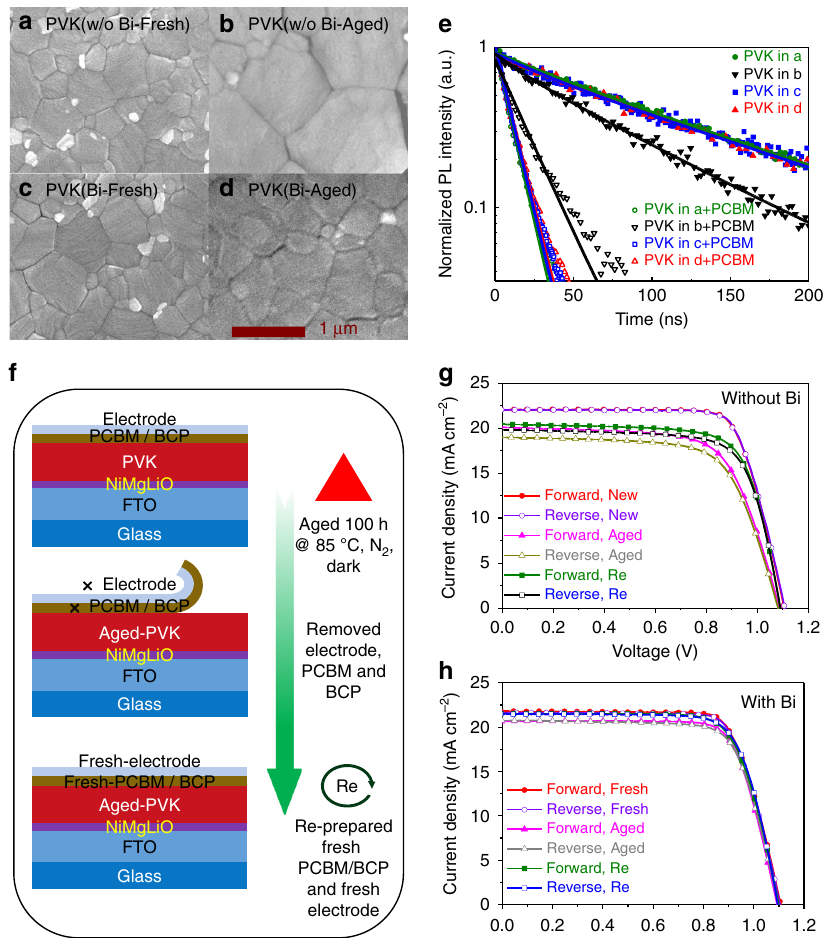
Fig. 5 Changes of PVK layers during thermal aging. a – d SEM images (scale bar: 1 µ m) and e time-resolved PL spectra of MAPbI 3 fi lms in devices with the con fi gurations Glass/MAPbI 3 /PCBM/BCP/Bi/Ag and Glass/MAPbI 3 /PCBM/BCP/Ag (i.e., with and without (w/o) Bi interlayers) before and after aging at 85 °C for 100 h in a N 2 fi lled glovebox in the dark. The MAPbI 3 fi lms were obtained by washing away the top PCBM/BCP/electrode layers. The re-prepared devices were prepared according to the schematic diagrams shown in ( f ) by re-preparing the PCBM/BCP/electrode layers. g , h J – V curves of the HPVKSCs without ( g ) and with ( h ) Bi interlayers, based on the fresh, aged MAPbI 3 fi lms, and the aged MAPbI 3 fi lms with re-prepared top layers. Forward Scan: from − 0.1 to 1.2 V. Reverse Scan: from 1.2 to − 0.1 V. The corresponding stabilized PCEs are shown in Supplementary Figure 10. Source data are provided